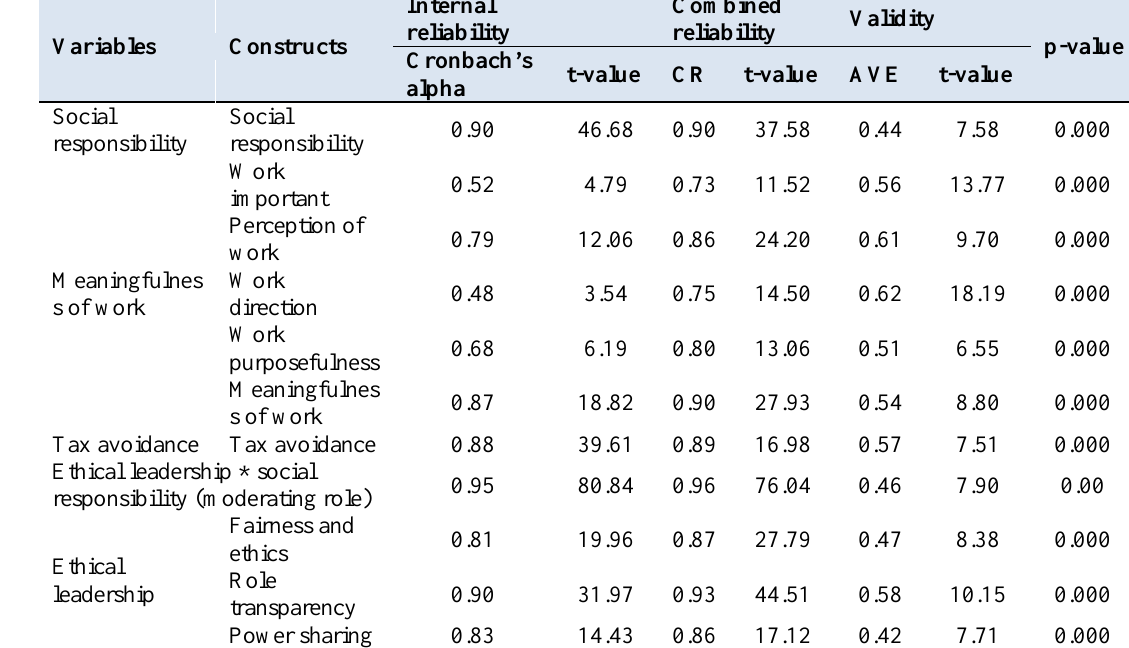
Table 3. Internal reliability, combined reliability, and convergent